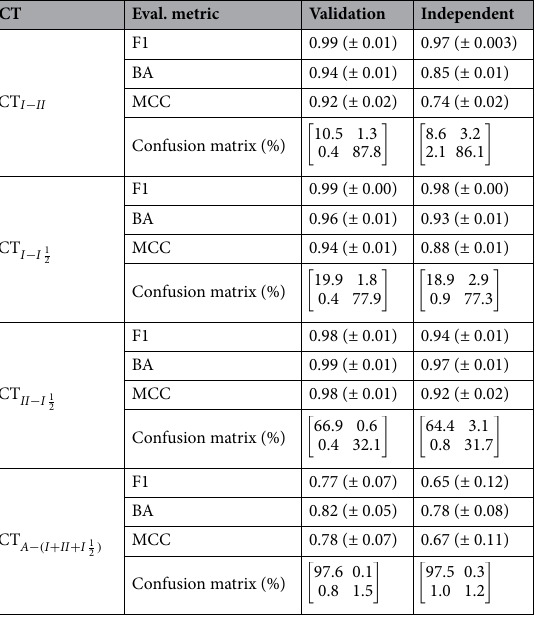
Table 2. Evaluation results for different classification tasks on validation and independent